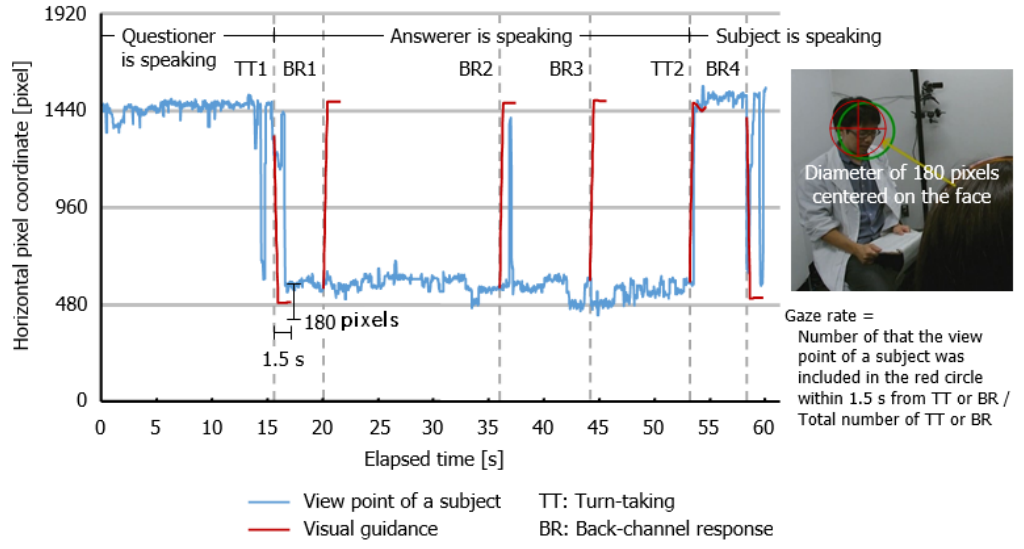
Figure 2. Example of the movement of view point at the semi condition, and the method to calculate the gaze